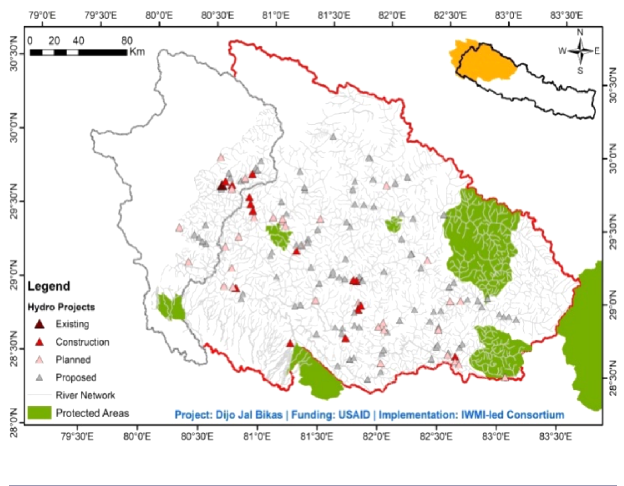
Fig. 2. Locations of hydropower projects in various stages of development and protected areas in the Karnali-Mohana and Mahakali basins, Western Nepal.